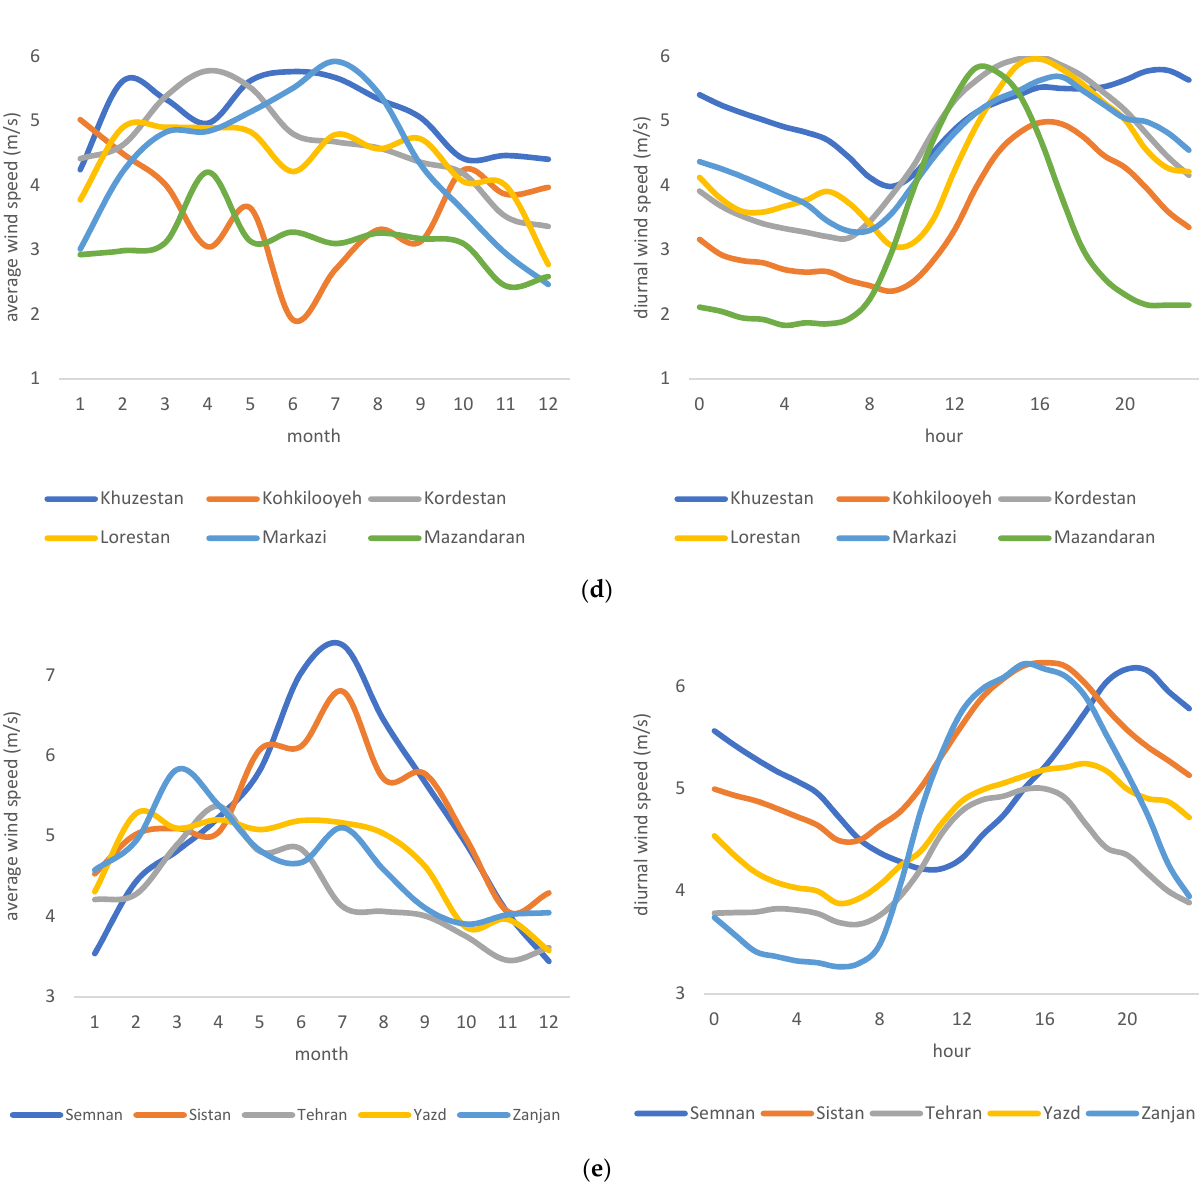
Figure 2. ( a – e ) Diurnal and seasonal variation of wind speed in Iranian provinces. To better understand, it is best to focus the analysis on provinces with larger wind power capacity or average annual wind speed of greater than 5 m/s (5 m/s is the minimum wind speed required for a utility-scale wind power plant). (Figure 3) ranks all provinces based on their average wind speed. Based on this figure, provinces of Qazvin, East Azerbaijan, Alborz, South Khorasan, Ardabil, Sistan Baluchestan, Qom, Razavi Khorasan, Semnan, and Khuzestan all register average annual wind speeds larger than 5 m/s. Figure 4 provides an overview and comparison of these provinces in detail. As can be seen, diurnal variation has the same pattern as before, with wind speed increasing and reaching its peak in the afternoon hours. There is also a seasonal variation in a few provinces. There are noticeable increases in wind speeds between May and October (with a peak in July) for South Khorasan, Razavi Khorasan, Qazvin, Semnan, and Sistan Baluchestan provinces.